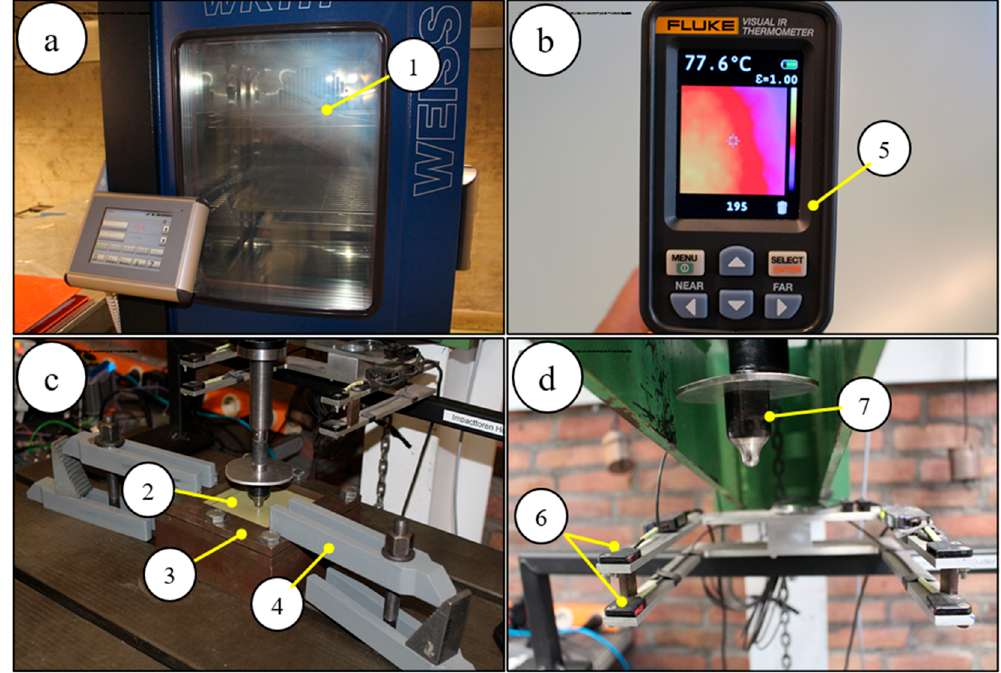
Figure 12. Instruments of the impact test set-up, ( a ) an air-circulated environmental chamber, (1) conditioning chamber; ( b ) the specimen cooled to around 75 °C, (5) thermal imaging camera; ( c ) the clamp covered circa 3 mm wide areas of the specimen edges, (2) GLARE specimen, (3) clamp, (4) clamp reinforcement; ( d ) an infrared timing gate, (6) infrared timing gate; (7) projectile.